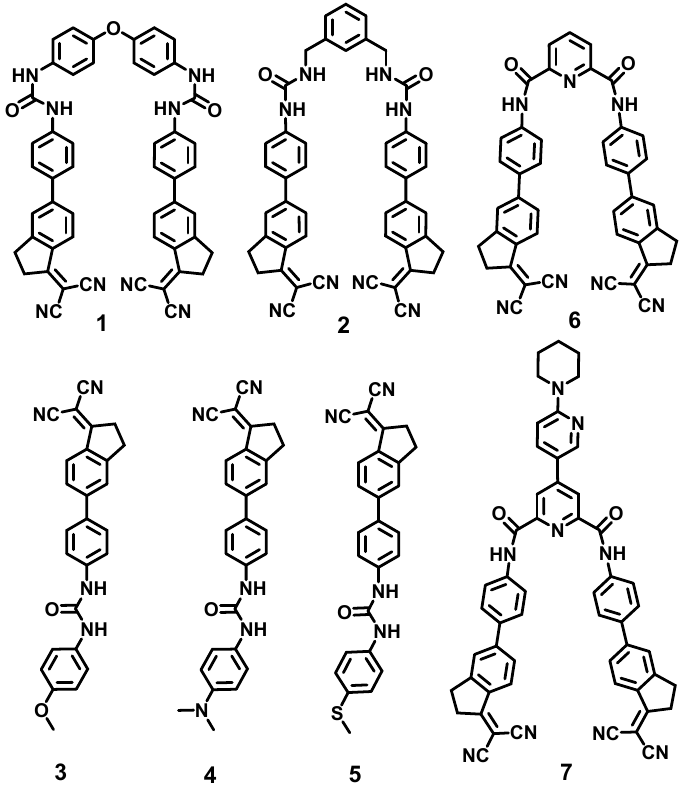
Figure 1. Chemical structures of the studied chemical probes.